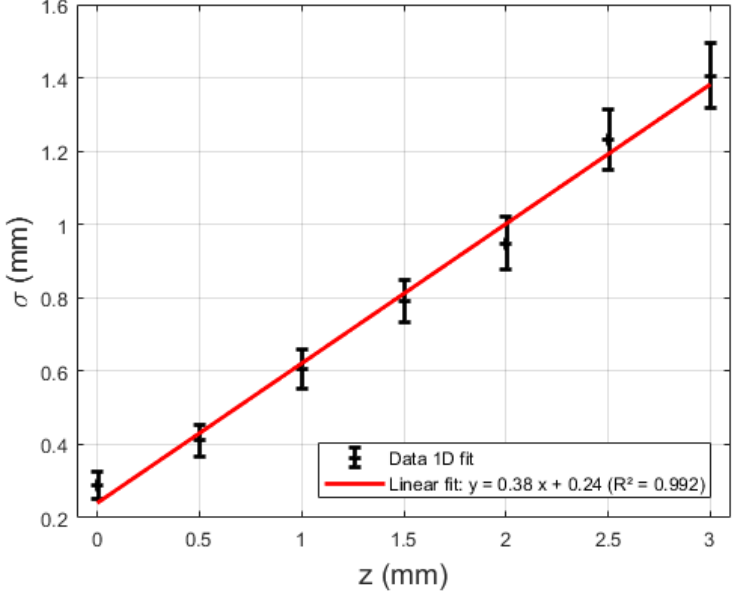
Figure 10. Beam with σ (mm) as a function of the axial beam coordinate z.